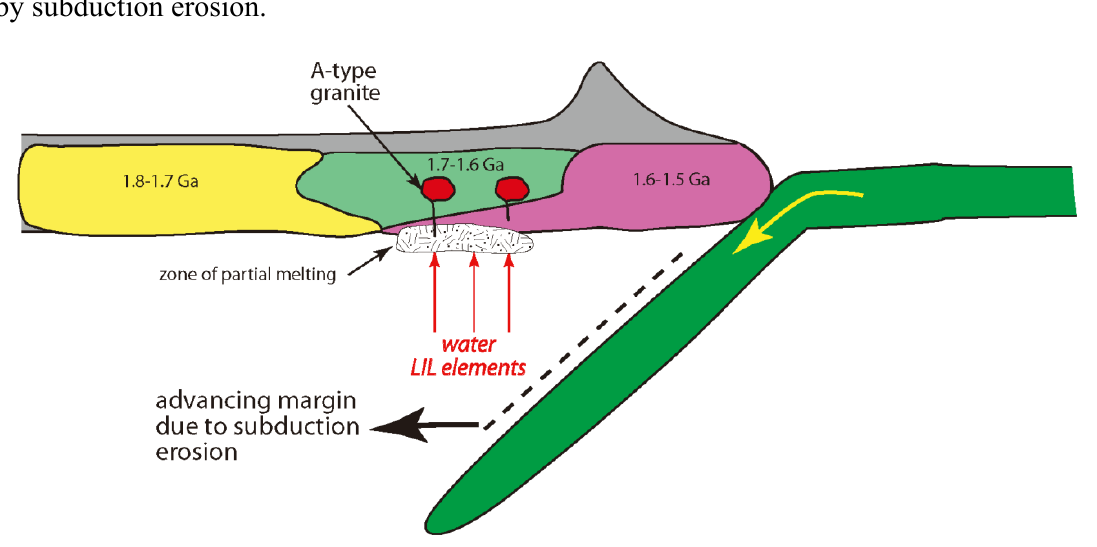
Figure 20. Diagrammatic cross section of the Great Proterozoic Accretionary Orogen along the southern margin of Laurentia showing advancing plate margin possibly caused by subduction